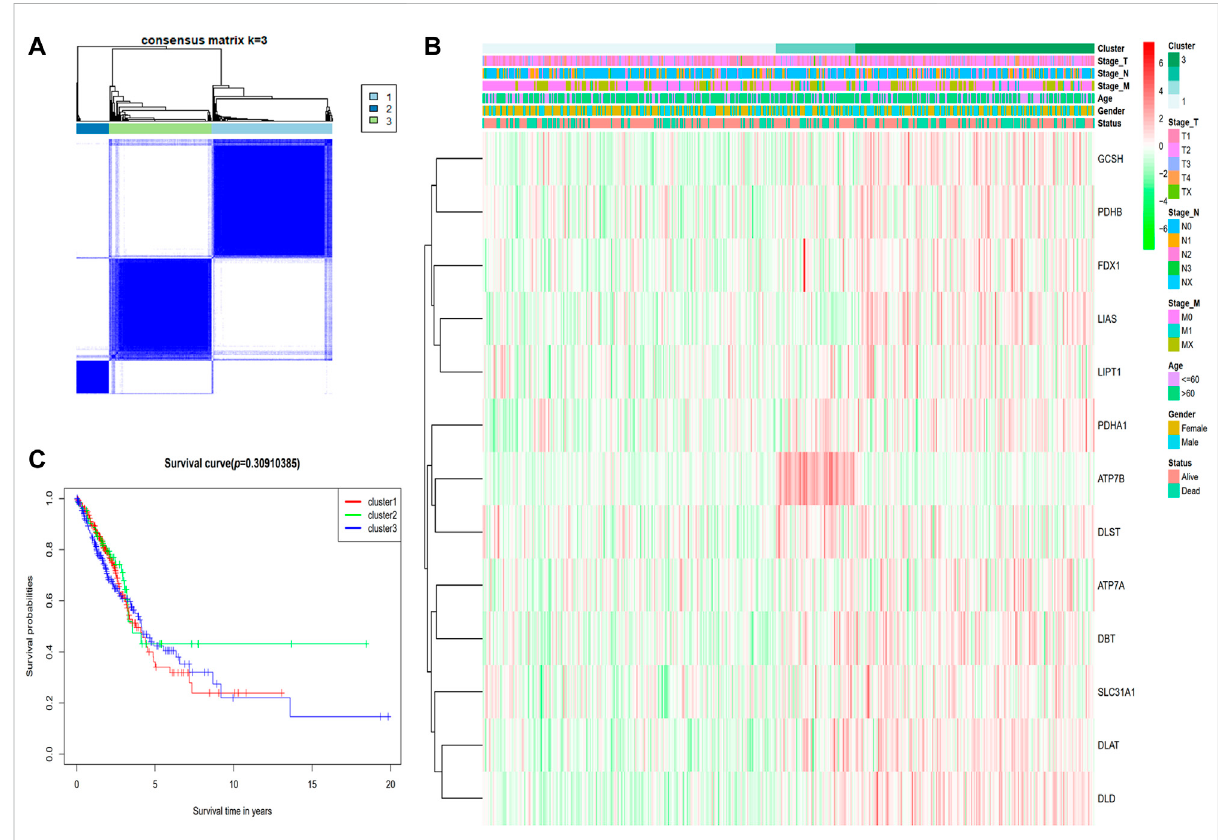
FIGURE 2 Tumor classi fi cation premised on the cuproptosis-associated genes. (A) Five hundred and twenty-six LUAD tumor samples were classi fi ed into three clusters utilizing the consensus clustering matrix (k = 3). (B) The heatmap depicting the clinical and pathological parameters of the three cuproptosis-related gene clusters. (C) Comparing OS time via KM survival analysis for the three